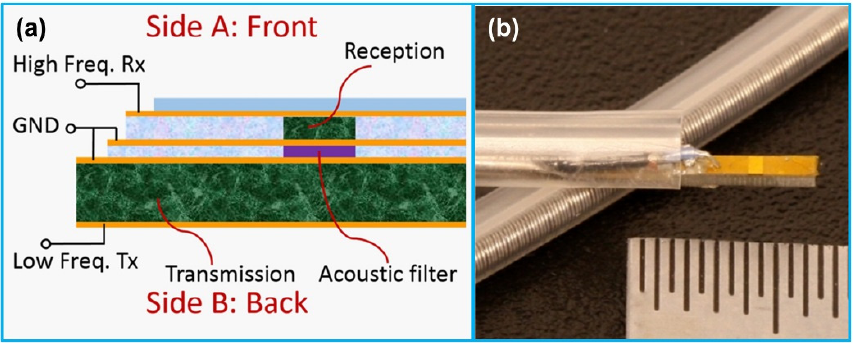
Figure 8. Stack dual frequency transducer for superharmonic IVUS imaging. ( a ) Schematic illustration of the dual frequency transducer structure; ( b ) A photograph image to show the fabricated transducer mounted inside a commercial catheter sheath. Reprinted from [136] with permission.